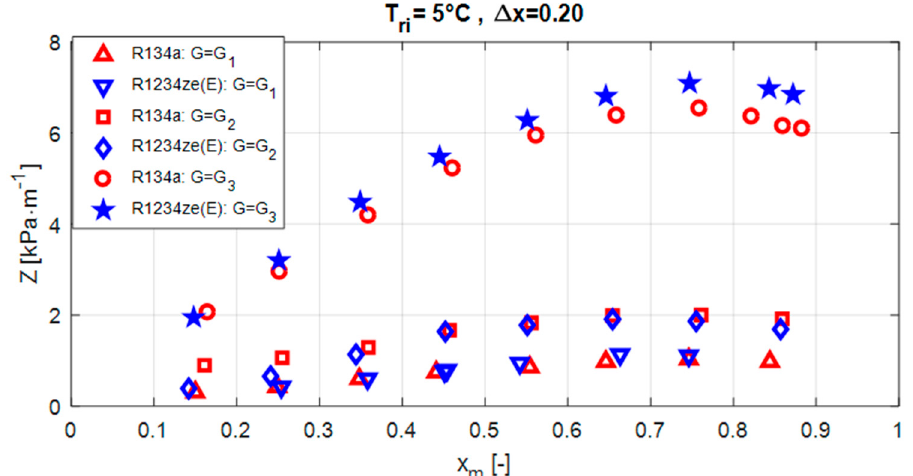
Figure 4. Pressure drop per unit length as a function of the mean quality for different mass fluxes (G 1 = 80 kg · m − 2 · s − 1 , G 2 = 110 kg · m − 2 · s − 1 , G 3 = 220 kg · m − 2 · s − 1